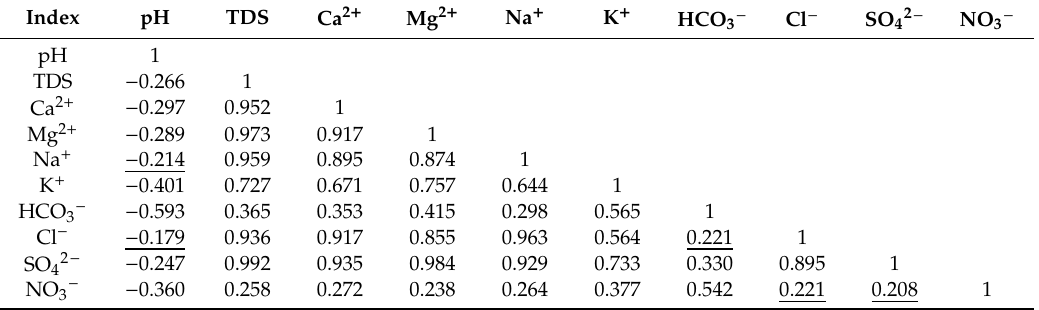
Table 4. The correlation coe ffi cient matrix between the various chemical indicators within groundwater samples collected from the Jinta Basin, China.